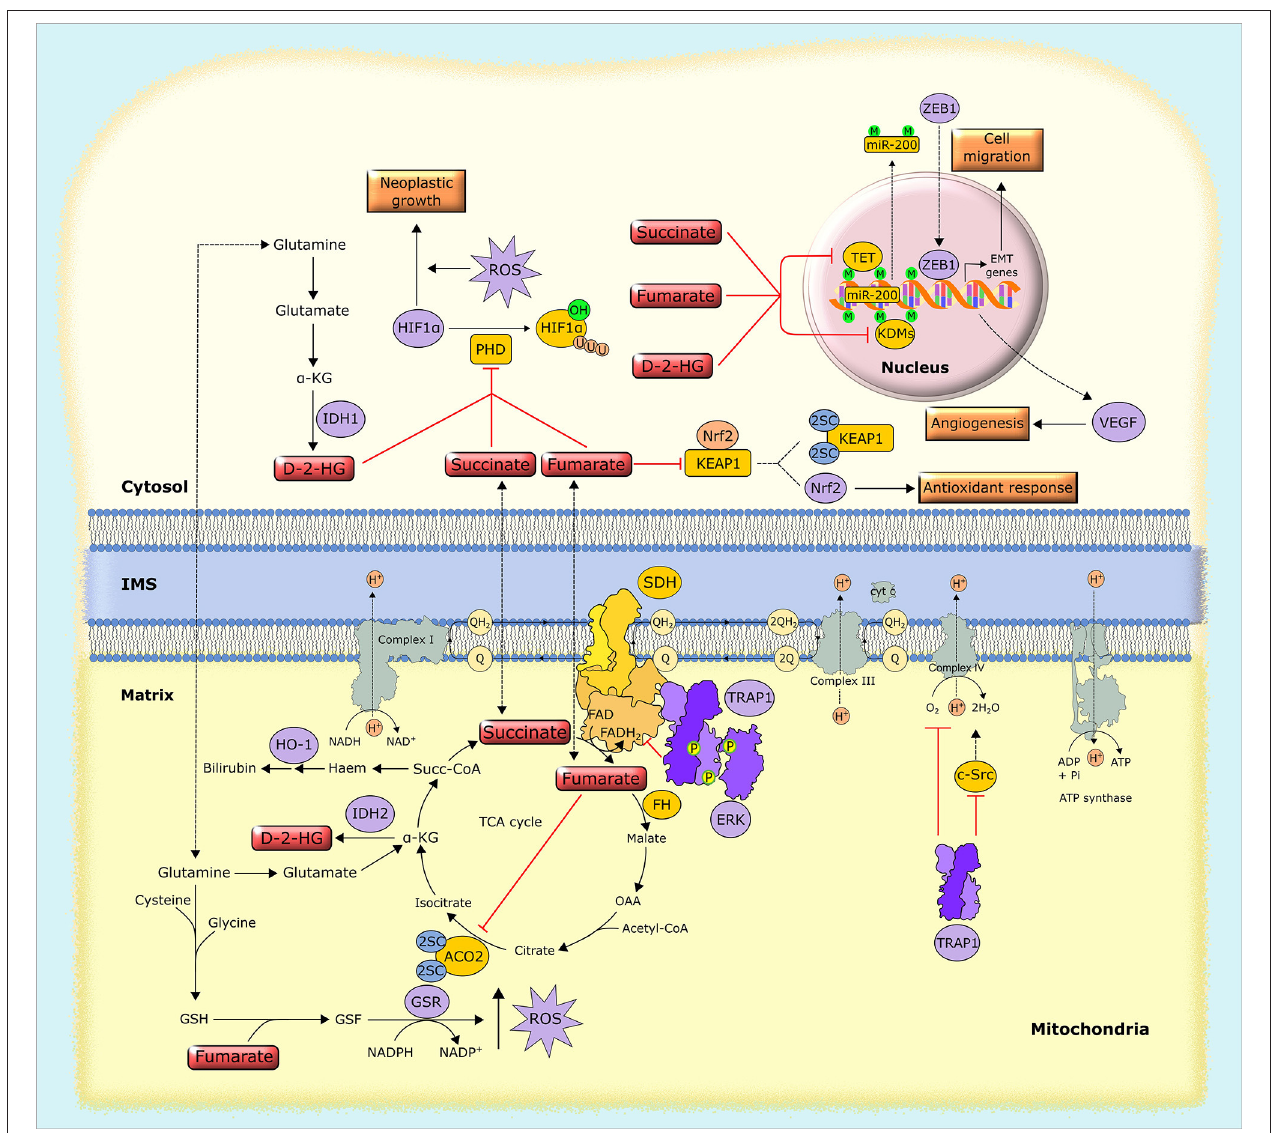
FIGURE 4 | Biochemical mechanisms of oncometabolite accumulation. Inactivating mutations in genes encoding succinate dehydrogenase (SDH) and fumarate hydratase (FH), as well as oncogenic mutations in isocytrate dehydrogenase (IDH), lead to the accumulation of succinate, fumarate and D-2-hydroxyglutarate (D-2-HG). These oncometabolites inhibit α -KG-dependent dioxygenases, including prolyl hydroxylases (PHDs), the ten-eleven translocation (TET) family of methylcytosine hydroxylases and histone lysine demethylases (KDMs), leading to HIF1 α stabilization and alterations in gene expression through epigenetic modifications. Separately, fumarate inactivates by succination both aconitase 2 (ACO2) and Kelch-like ECH associated protein 1 (KEAP1), which results in the activation of the antioxidant pathway mediated by NRF2, and also generates succinated glutathione (GSF), an alternative substrate to glutathione reductase